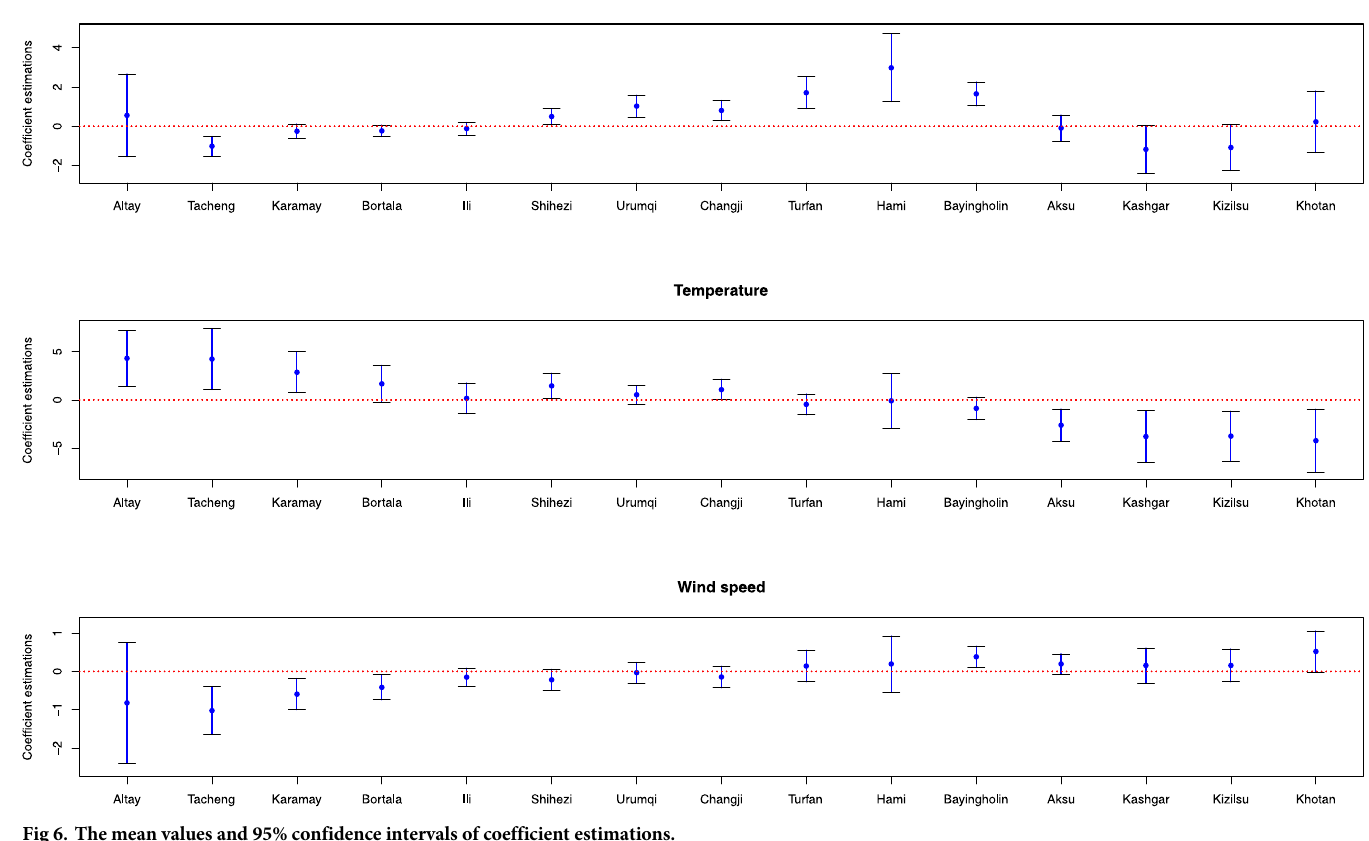
According to the GTWPR model, Fig 6 shows the mean values and 95% confidence intervals of coefficient estimations. The mean values are represented by the dots. The 95% con- fidence interval is represented by the upper and lower lines. There is a significant spatiotempo- ral non-stationary between the climatic factors and HFM disease. With the increase of the rainfall, the number of HFM cases increases in Shihezi, Urumqi, Changji, Turfan, Hami, and Bayingholin, and decreases in Tacheng, Karamay, Bortala, Ili, Kashgar, and Kizilsu. The rise of temperature leads to an increase in the number of patients in Altay, Tacheng, Karamay, Bor- tala, Shihezi, and Changji. The spread of HFM disease is also affected by wind speed. High wind speed brings unfavorable influence to the incidence in Khotan, Bayingholin, and Aksu, � ^ and has different results in Tacheng, Karamay, Bortala, Ili, and Shihezi. Let b ð j ¼ 1 ; 2 ; 3 Þ be j the mean value of ^ b ð u ; v ; t Þ at the k th times. Fig 7 visualizes the mean values of coefficient jk ik ik k estimations in the GTWPR model. It reflects the relationship between HFM disease and these